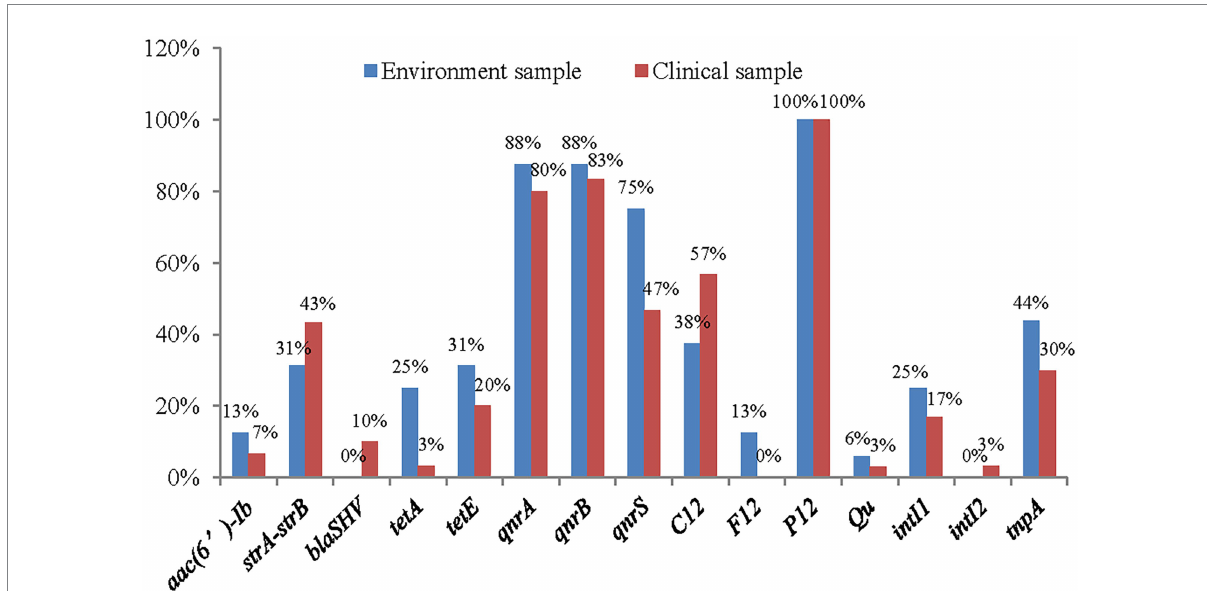
FIGURE 6 The distribution of antimicrobial resistance genes in clinical strains and environment strains of A.